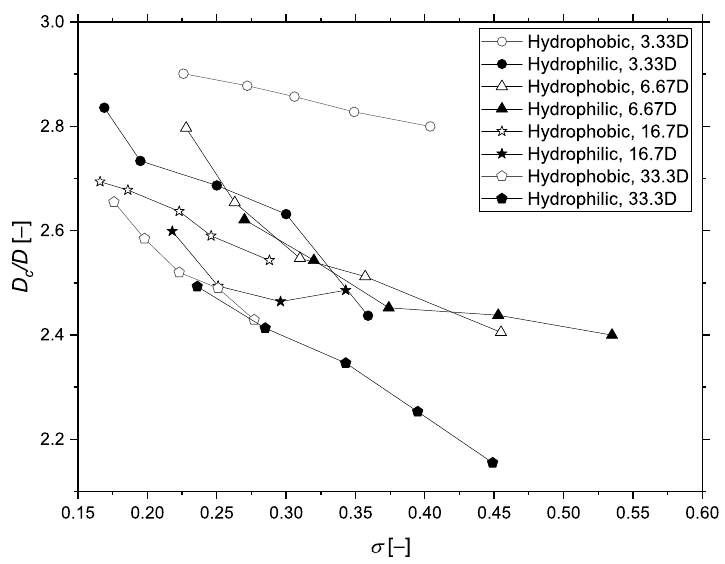
Figure 9. Relationship between dimensionless cavitation diameter and cavitation number. Similarly, in Figure 9, for the same water depth, the cavitation diameter of the hy- drophobic projectile was larger than that of the hydrophilic projectile. With the increase in water depth, the diameter of the cavity also decreases like the change rule of the cavitation length with water depth in Figure 8, which was consistent with the findings of Shi et al. [10]. Figure 10 shows the comparison of cavitation profile at water depths of 3.33D and 16.7D at a certain cavitation number. The abscissa and ordinate are the dimensionless length and diameter of the cavity, respectively. Obviously, the cavitation contour inclined upward, that is, to the free surface, in the 3.33D condition, while in the 16.7D condition, the cavitation contour was basically axisymmetric.